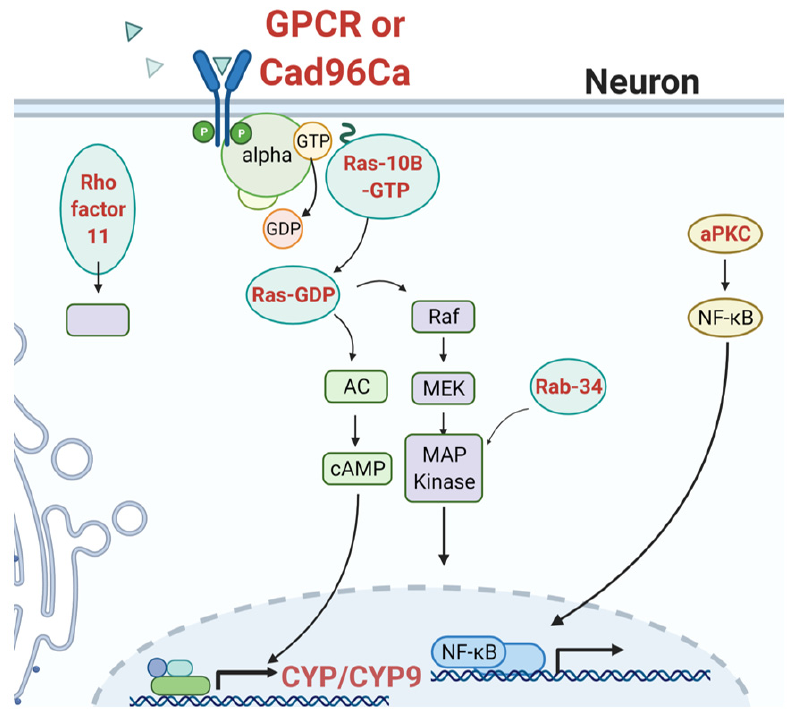
Figure 3. Signaling mechanisms contribute to pyrethroid resistance. Activation of the signaling mechanism could occur as part of the wound response [118,119,123]. GPCR signaling and subsequent upregulation of detoxification enzyme expression has been described in Culex spp. [34,117]. Increased resistance was observed in the presence of elevated cyclic adenosine-monophosphate (cAMP). Effectors in red font are genetically associated with pyrethroid resistance in natural Ae. aegypti collections from Mexico [31]. Atypical protein kinase C (aPKC), which helps maintain cell polarity, could activate NF- κ b upregulation of resistance genes [122]. Figure prepared using Biorender, with permission (Biorender.com, accessed on 22 March 2021).